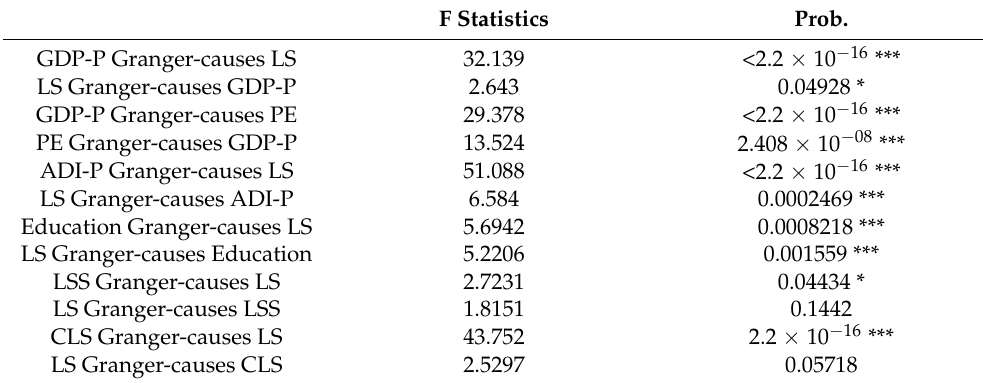
Table 13. The results of Granger’s causality